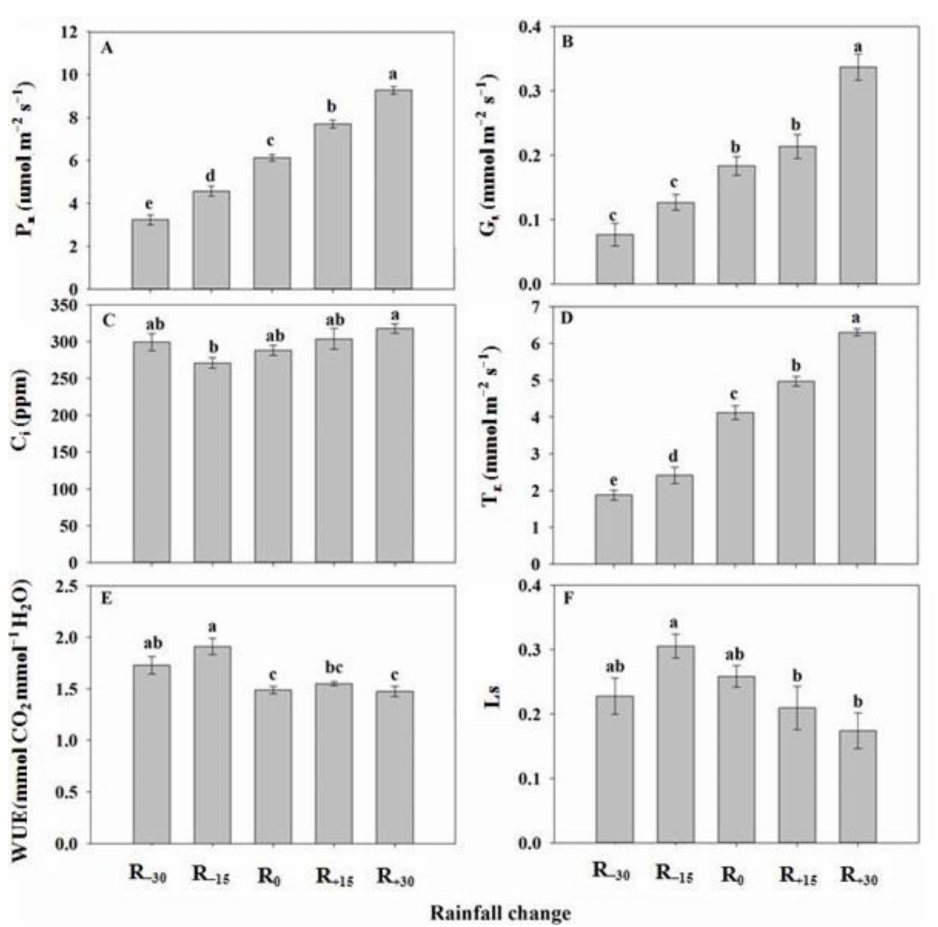
Figure 2. Changes in the photosynthetic characteristic parameters of Gymnocarpos przewalskii leaves under rainfall change. ( A ): P n ; ( B ): G s ; ( C ): C i ; ( D ): T r ; ( E ): WUE; ( F ): L s ; P n , net photosynthetic rate; G s , stomatal conductance; T r , transpiration rate; C i , intercellular CO 2 concentration; WUE, water-use efficiency; L s , stomatal limitation; R 0 , mean monthly rainfall from May to August during the period from 1961 to 2018; R − 30 , R 0 decreased by 30%; R − 15 , R 0 decreased by 15%; R +15 , R 0 increased by 15%; R +30 , R 0 increased by 30%. The vertical bars represent the means ± SE (n = 3), and different lowercase letters above the bars indicate significant differences among the treatments ( p <